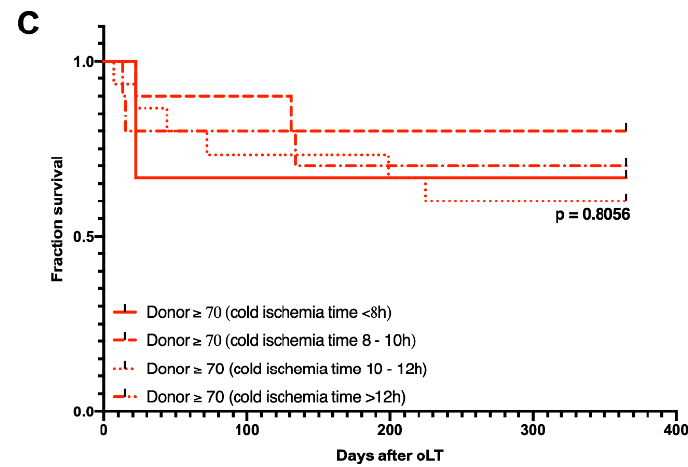
Figure 4. ( A ) Distribution of cold ischemia subcategories and Kaplan–Meier curves demonstrating the impact of cold ischemia time of one-year patient survival in ( B ) donor age ≥ 65–69 years and ( C ) donor age ≥ 70 years.